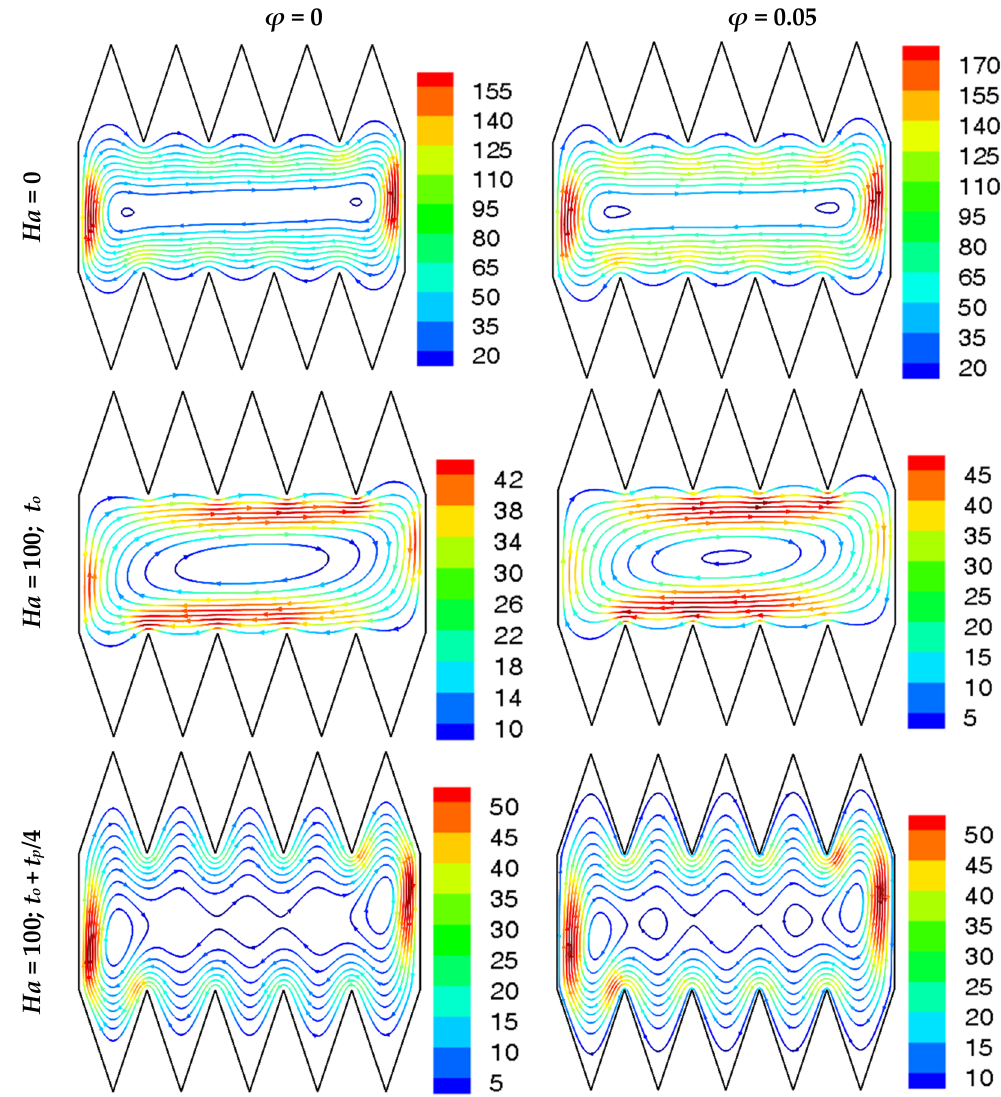
Figure 5. Streamlines for Ha = 0 and Ha = 100 for Ra = 10 6 , f = 4 and A/L =